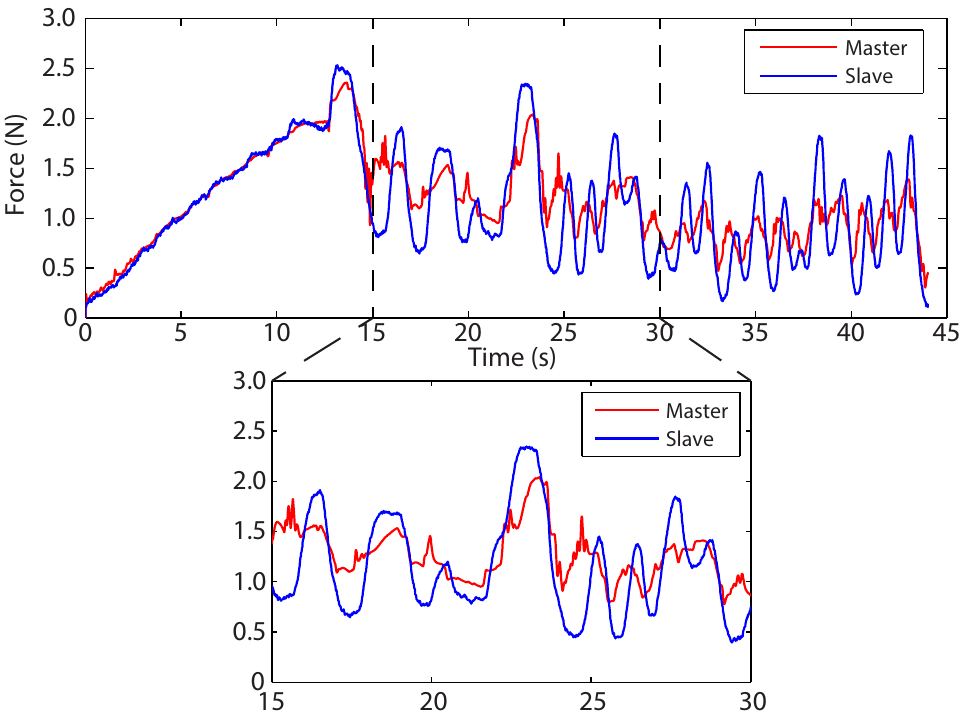
Figure 11. Force–time profile using the Kelvin–Voigt force model as the virtual environment. The high- lighted section demonstrates how the master feedback force inconsistently follows the slave environ- ment